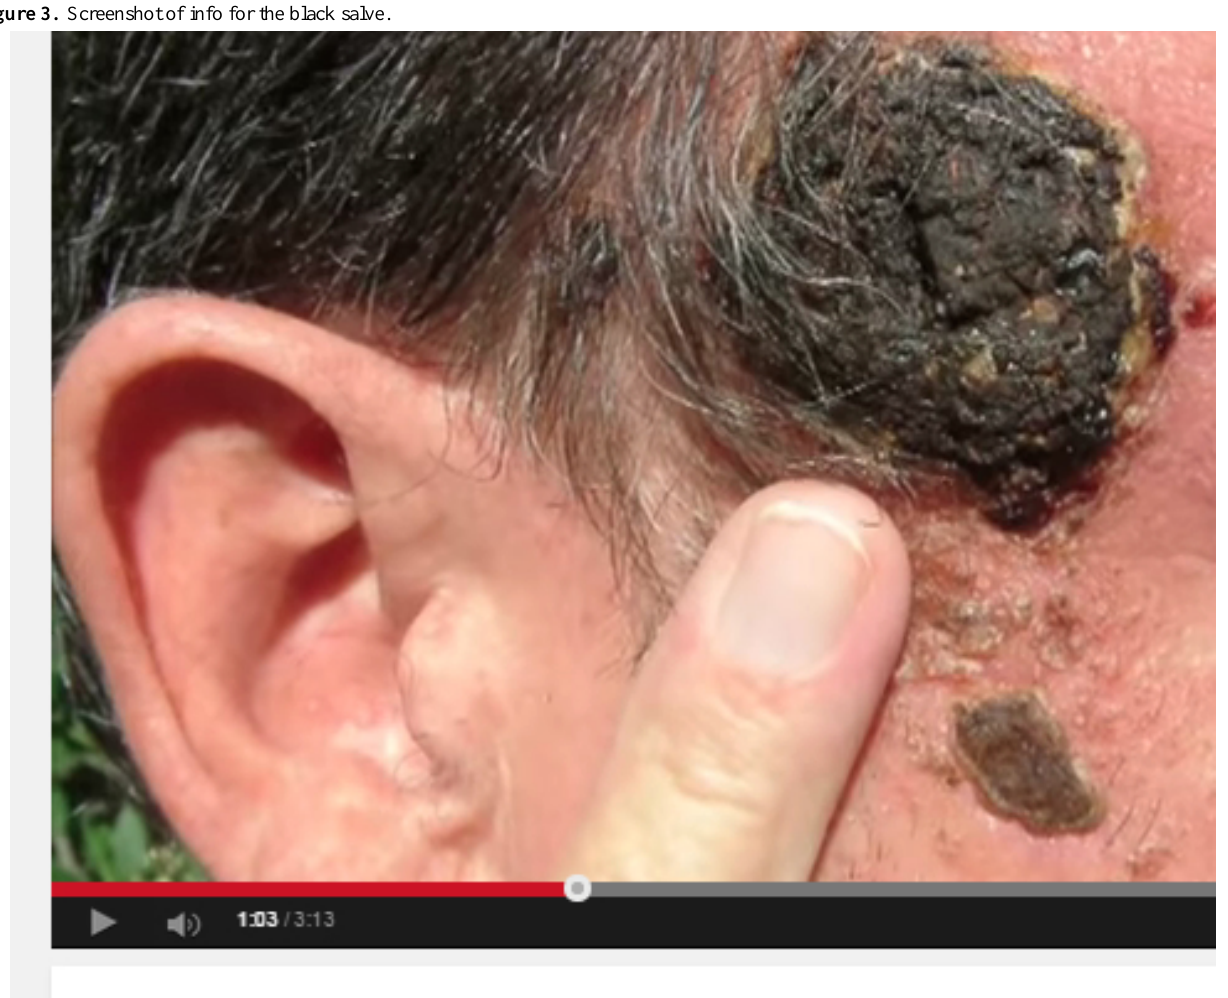
Figure 3. Screenshot of info for the black